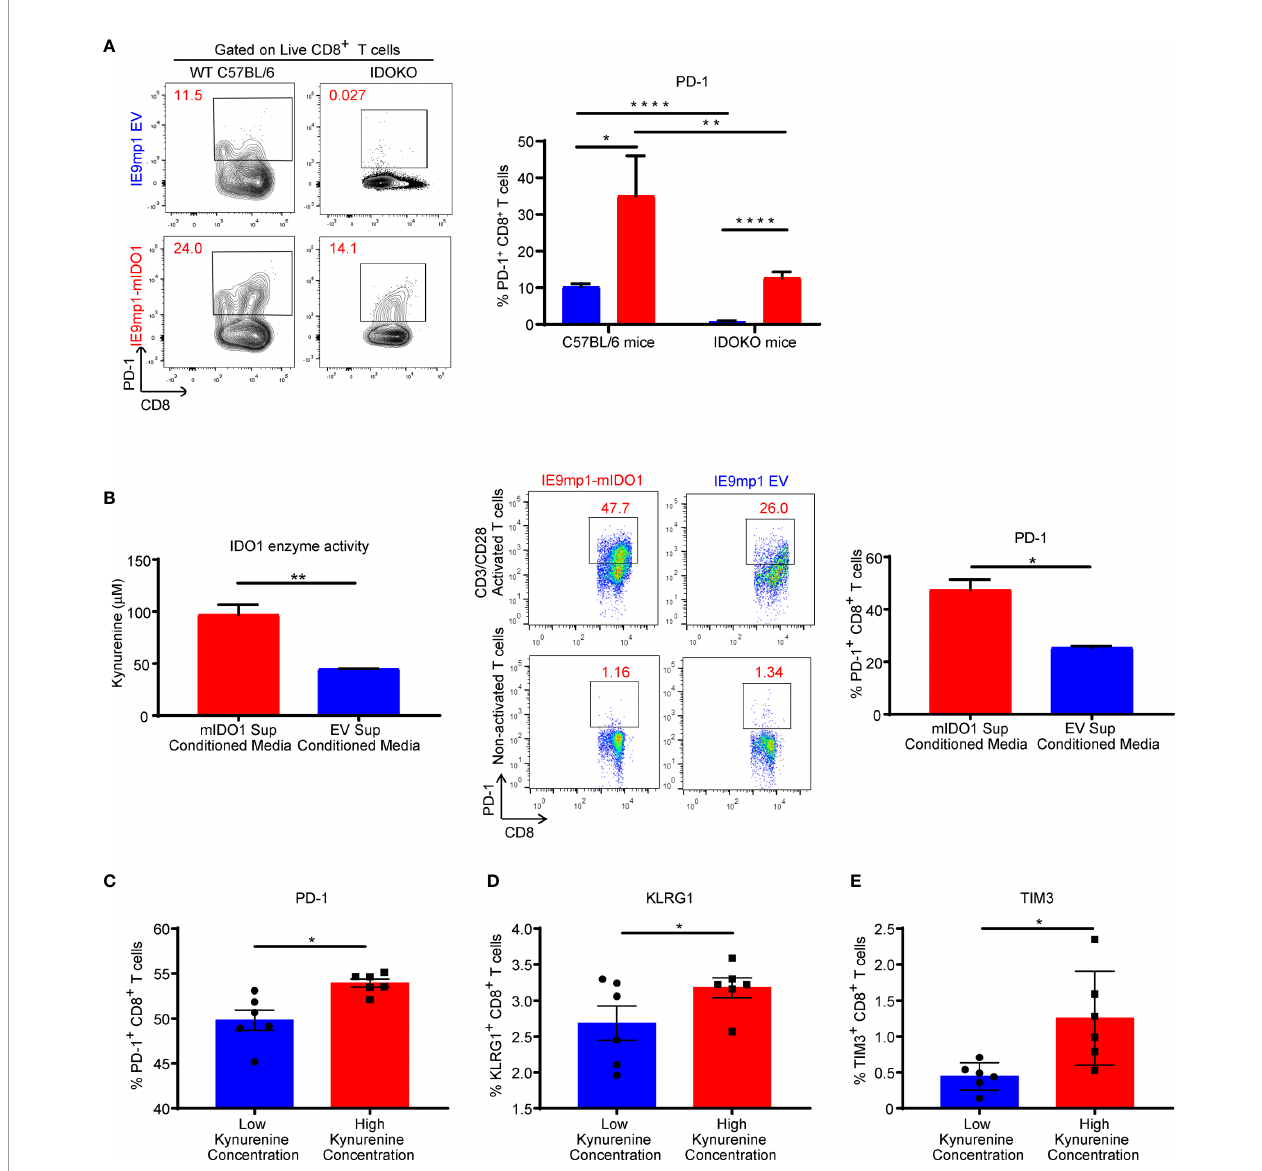
FIGURE 4 | Kynurenine mediates upregulation of inhibitory receptor on CD8+ T cells. (A) Frequency of PD1+CD8+ T cells in tumor ascites from WT C57BL/6 or IDOKO mice challenged i.p. with 1x10e7 IE9mp1-EV (n=5) or IE9mp1-mIDO1 (n=6) tumor cells on Day 48, as determined by fl ow cytometric analysis. ( B , left) Kynurenine concentrations measured in IE9mp1-EV and IE9mp1-mIDO1 tumor cell culture supernatant by colorimetric assay. ( B , right) Frequency of PD1+CD8+ T cells, from WT C57BL/6 mice spleens, co-cultured with 1µg/mL anti-CD3/CD28 in IE9mp1-mIDO1 or IE9mp1-EV tumor cell culture supernatant for 48 hr. PD1+CD8+ T cell frequency was determined by fl ow cytometric analysis. (C) PD-1, (D) KLRG1, and (E) TIM3 expression analyzed by fl ow cytometric analysis on T lymphocytes from WT C57BL/6 mice activated with 1µg/mL anti-CD3/CD28 and with treated kynurenine. *p < 0.05, **p < 0.01, ****p < 0.0001, by Student ’ s t test (A – E) . The data represent means ± SEM of three independent experiments performed in